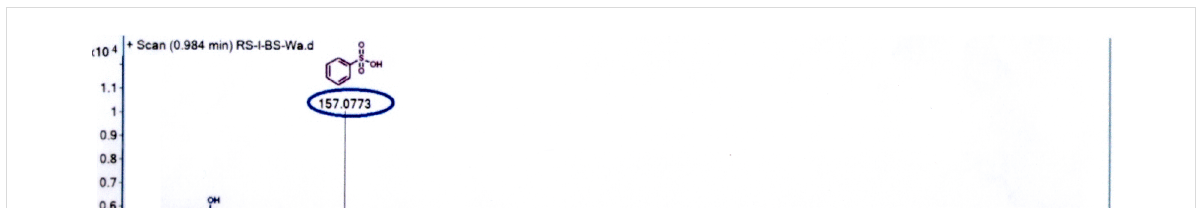
Scheme 4: Mechanism for the formation of substituted pyrazinones.